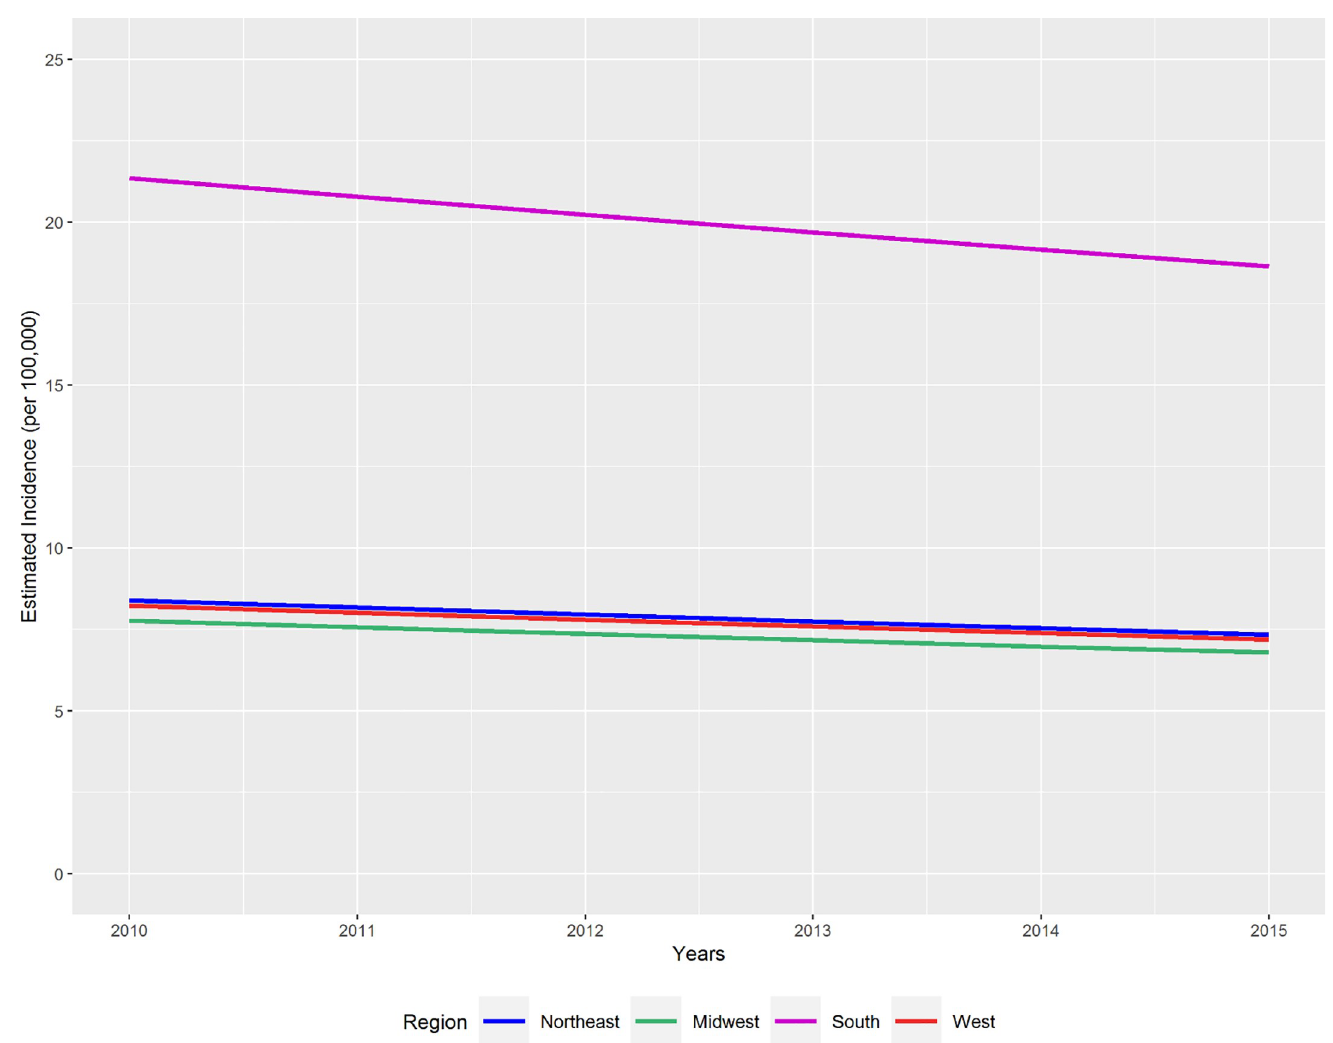
Fig 1. Fitted HIV incidence rate by region, United States 2010–2015. Fitted HIV incidence rate determined using a mixed-effects Poisson regression model including region, a fixed effect for year, and a random